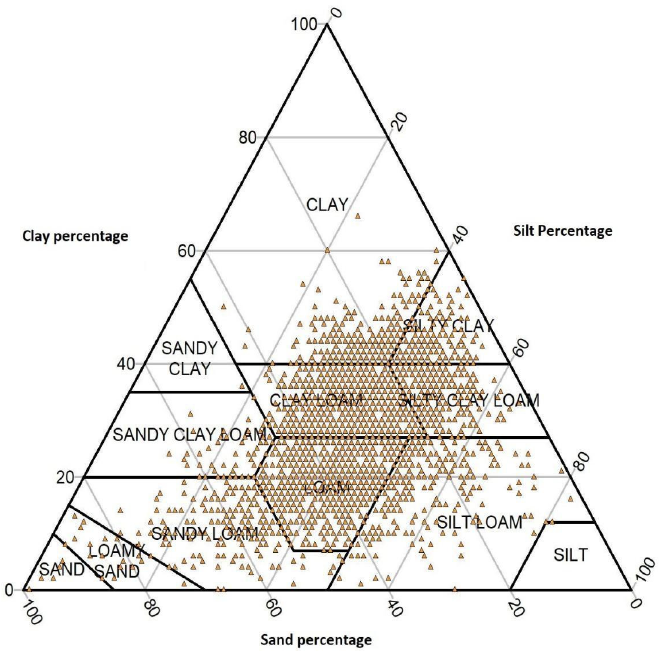
Figure 3. Soil texture distribution of study area plotted on the USDA soil texture triangle. Table 4. The best-fitted semi-variogram results on sand silt and clay soil